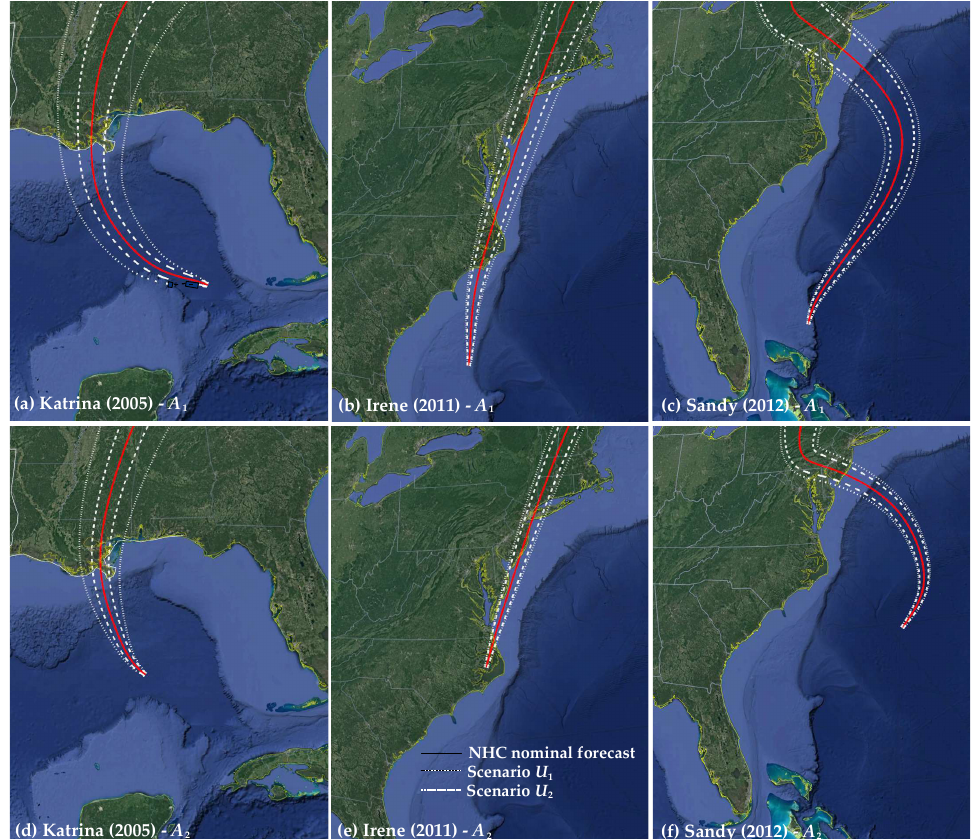
Figure 4. Storm tracks for hurricanes Katrina (2005), Irene (2011), and Sandy (2012), considering two advisories in each case: NHC nominal forecast (red solid line), as well as the track corresponding to 1 standard deviation for the cross-track variability based on the forecast errors of the year of the storm (scenario U 1 in dotted line), or the 2020 forecast errors (scenario U 2 in dash-dotted line). Top row corresponds to advisory A 1 and bottom to advisory A 2 .